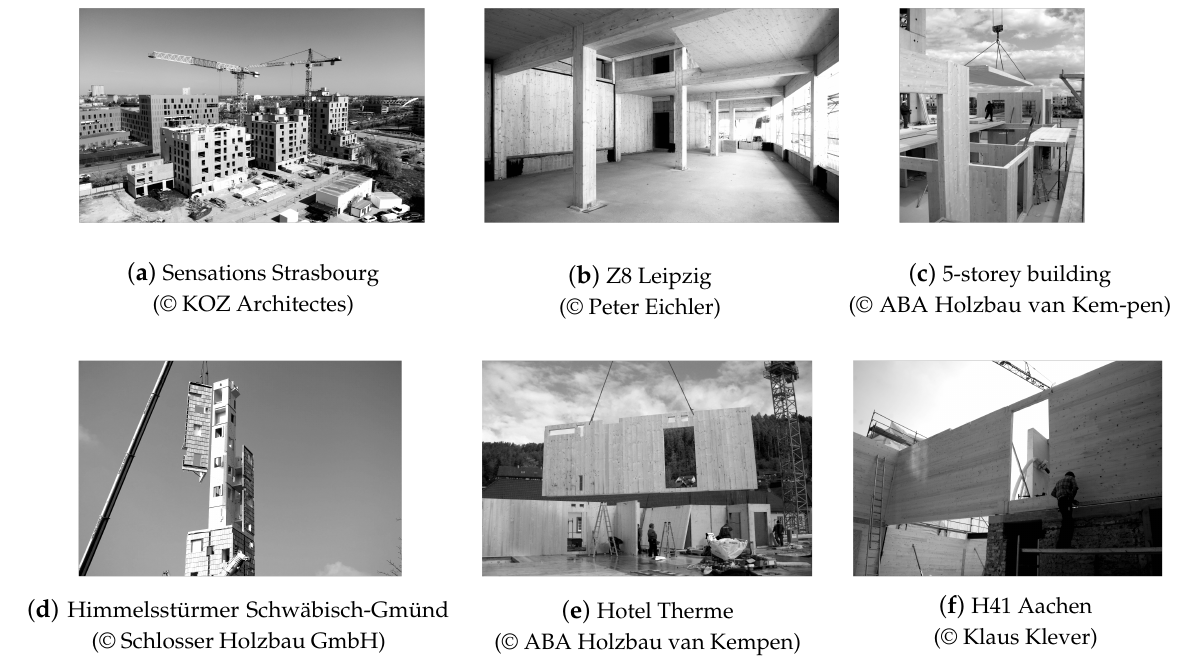
Figure 3. Impressions from projects using cross laminated timber panels.